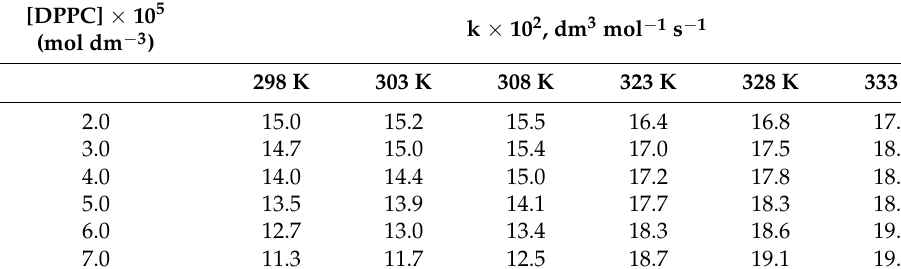
Table 1. Second-order rate constants for the reduction of cobalt(III) complex ion by Fe 2+ in DPPC medium under various temperatures; cis-[Co(ip) 2 (C 12 H 25 NH 2 ) 2 ](ClO 4 ) 3 = 4 × 10 − 4 mol dm − 3 , μ = 1.0